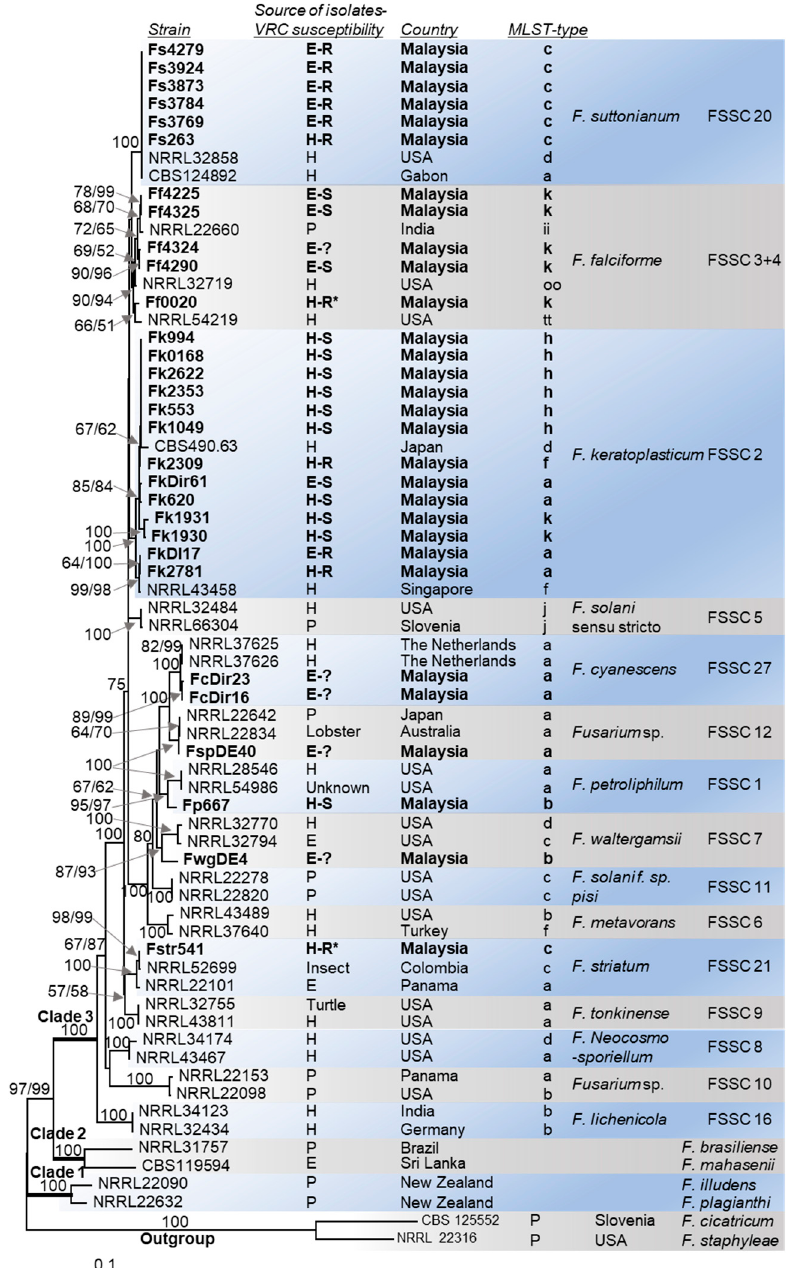
Figure 1. Maximum likelihood (ML) phylogram of the concatenated TEF1 - α and RPB2 sequences for the 30 Malaysian FSSC isolates and 37 publicly available sequences of globally distributed FSSC isolates. DNA sequences of two close relatives ( F. cicatricum and F. staphyleae ) were used as the outgroup. Isolates characterised in this study are highlighted in bold font. The source of individual isolates (E = environmental, H = hospital, P = plant) is shown in the column to the right of the strain identifier. The voriconazole resistant (MIC > 32 mg/L) isolates with the 23 bp CYP51A promoter deletion and the voriconazole susceptible (MIC ≤ 12 mg/L) isolates are indicated with R and S, re- spectively. The voriconazole susceptibilities of isolates marked with a question mark (?) were not determined. Technical issues prevented the confirmation of the 23 bp CYP51A promoter deletion in the voriconazole resistant F. falciforme (Ff0020) and F. striatum (Fstr541) isolates (marked with aster- isks; *). The roots, with 100% bootstrap support, of the three major FSSC clades (clades 1, 2 and 3) are in bold. Numbers at internodes represent the percentage maximum parsimony (MP) and maxi- mum likelihood (ML) bootstrap support (MP-BS/ML-BS) of 1000 replicates; a single value means that both values were identical. The scale bar indicates the number of nucleotide substitutions per position.